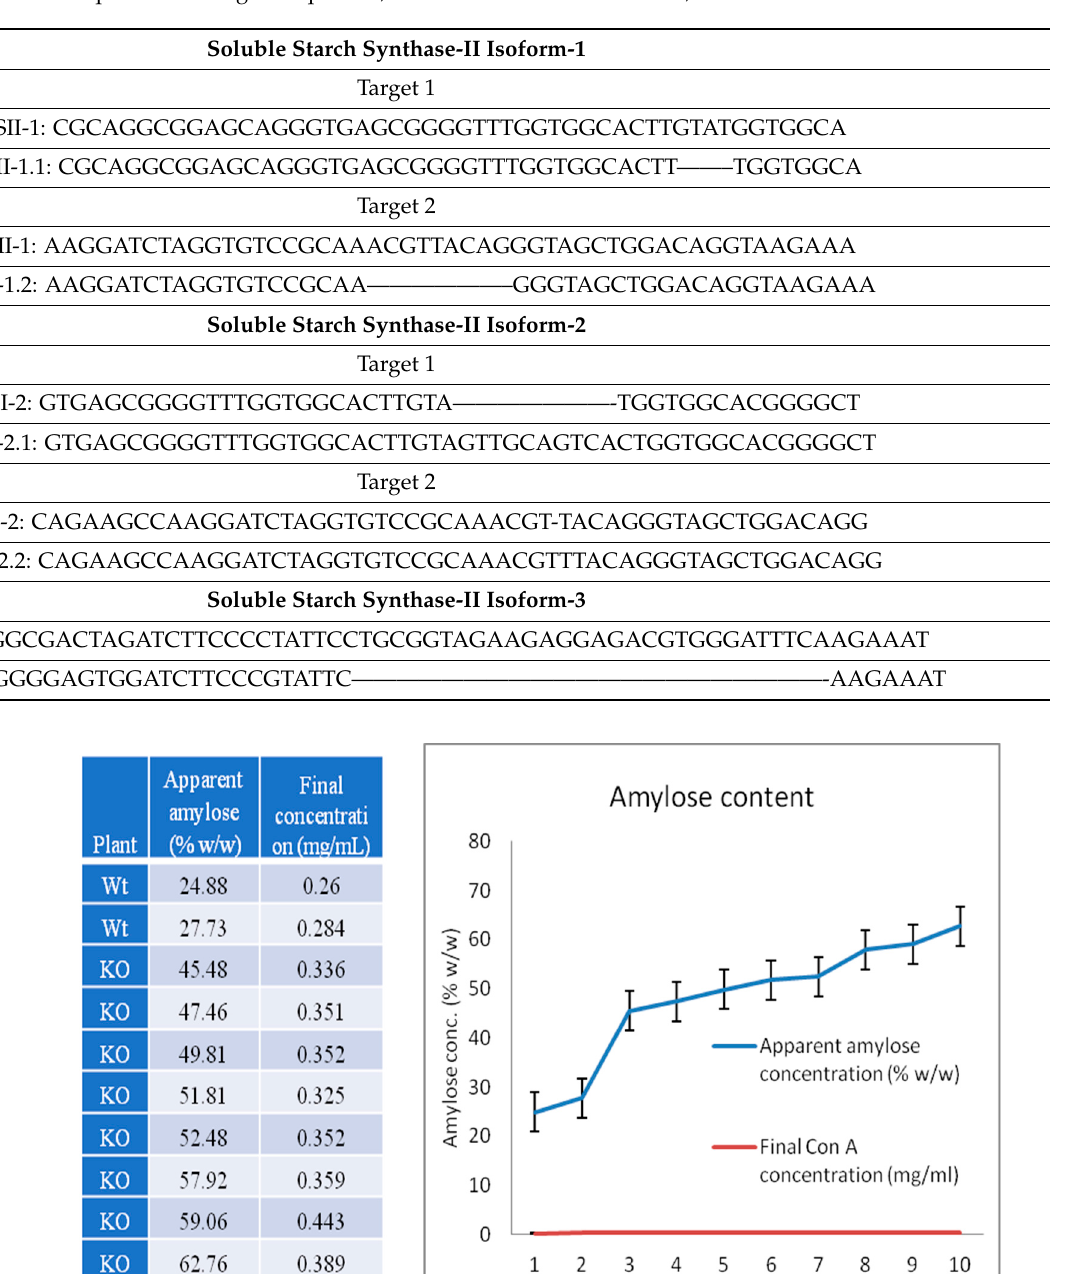
Table 1. The results of sequencing of SSSII-1, SSSII-2, and SSSII-3 mutant lines. CRISPR/Cas9 was used for editing the SSSII-1, SSSII-2, and SSSII-3 genes. The bold nucleotides are PAM motifs, the yellow sequences are targets sequences, deletions are shown in dashes, and red nucleotides are insertions.